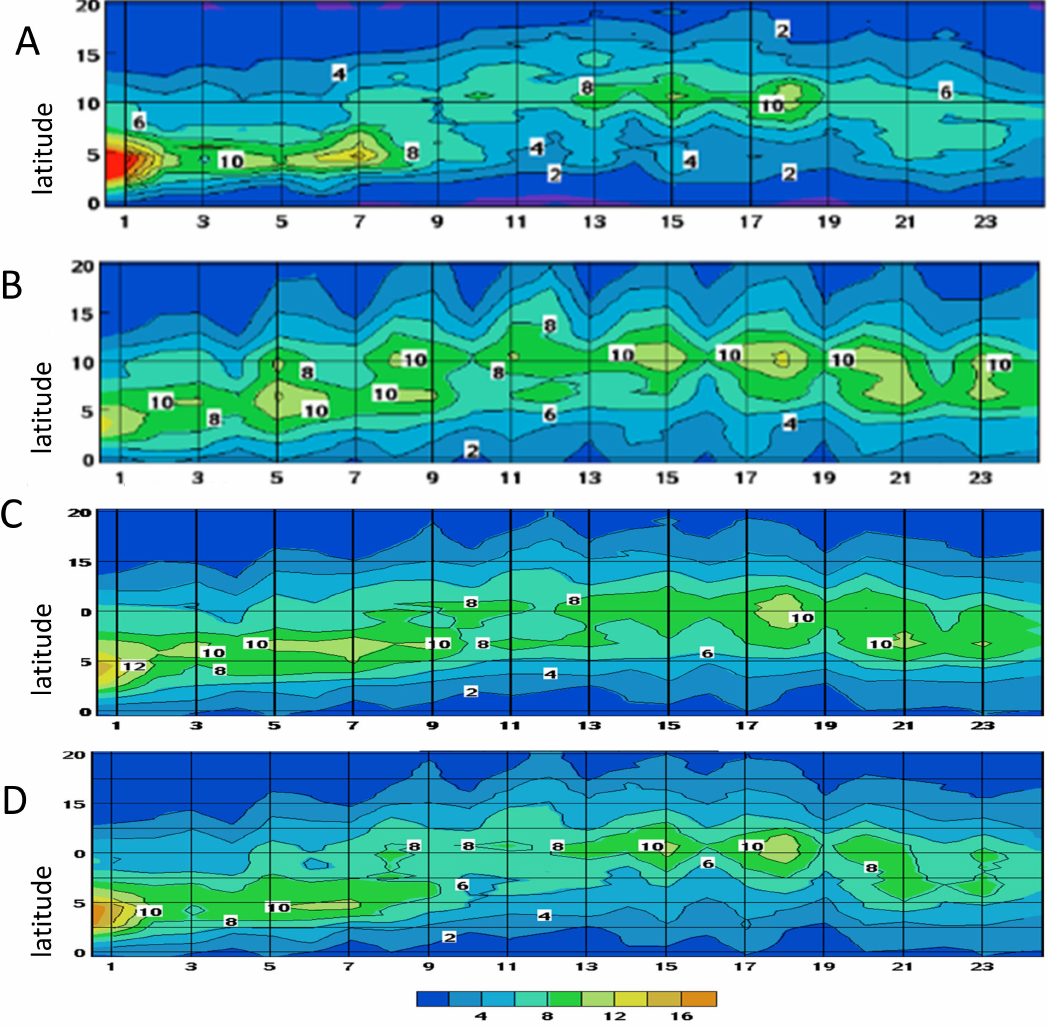
Figure 3. Pentad (5-day mean) precipitation rates (mm day − 1 ) from June–September versus latitude (Hovmöller), averaged over 10 ◦ W to 10 ◦ E and 1998–2002. Pentad 1 is the 1–5 June mean. ( A ) TRMM; ( B ) RM3nc forced by ModelE without bias corrections; ( C ) RM3bc forced by ModelE with bias corrections to LBCs and SST; ( D ) RM3sst forced by ModelE with bias corrections to only